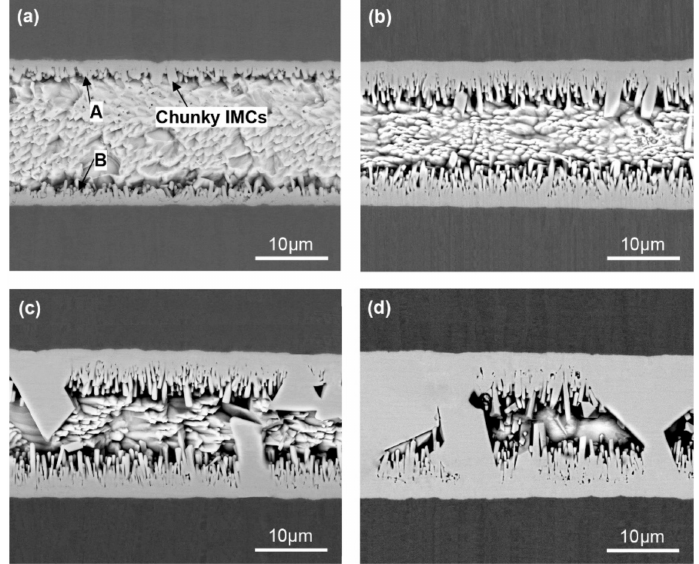
Figure 4. Cross-sectional SEM microstructure of Ni / Sn / Ni micro-joints as varying soldering times: